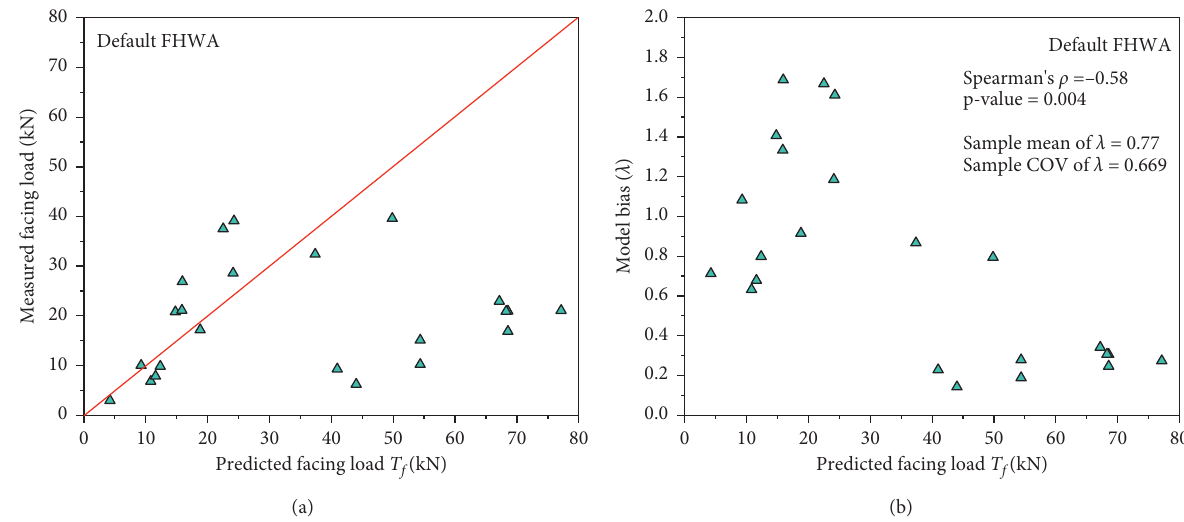
Figure 2: Analyses of accuracy of the default FHWA simplified facing load model: (a) measured versus predicted facing load; (b) model bias versus predicted facing load.